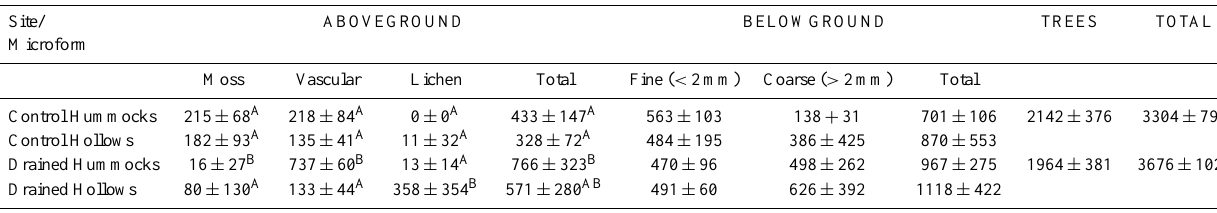
Table 3. Ground-layer and tree biomass (gm − 2 ) at control and drained sites. Site/ ABOVEGROUND BELOWGROUND TREES TOTAL Microform Moss Vascular